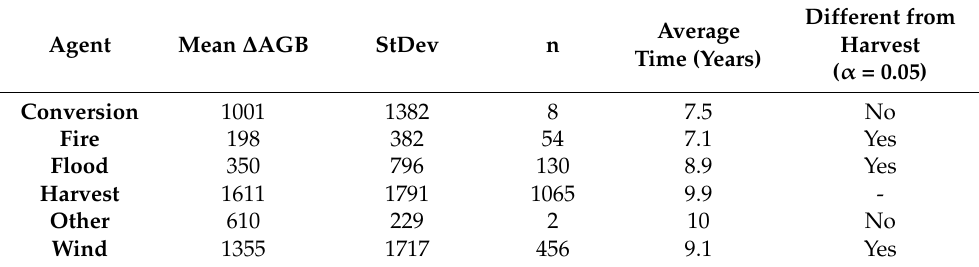
Table 6. Modeled above ground biomass accumulation (kg/ha/yr.) (5–15 years following disturbance).